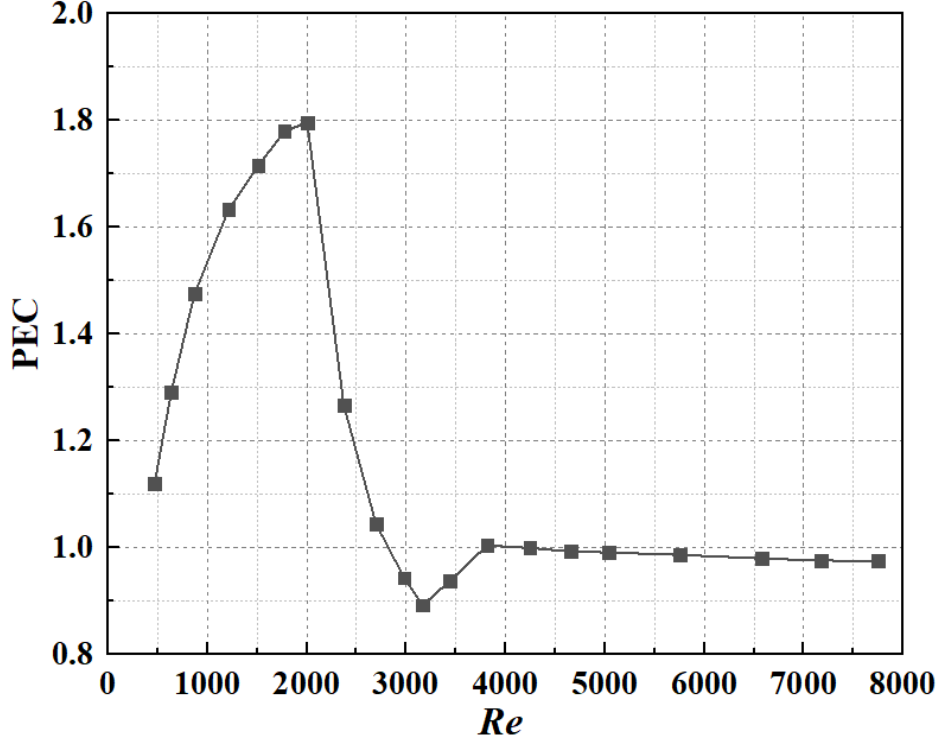
Figure 32. Variation in performance evaluation criteria with Reynolds number.